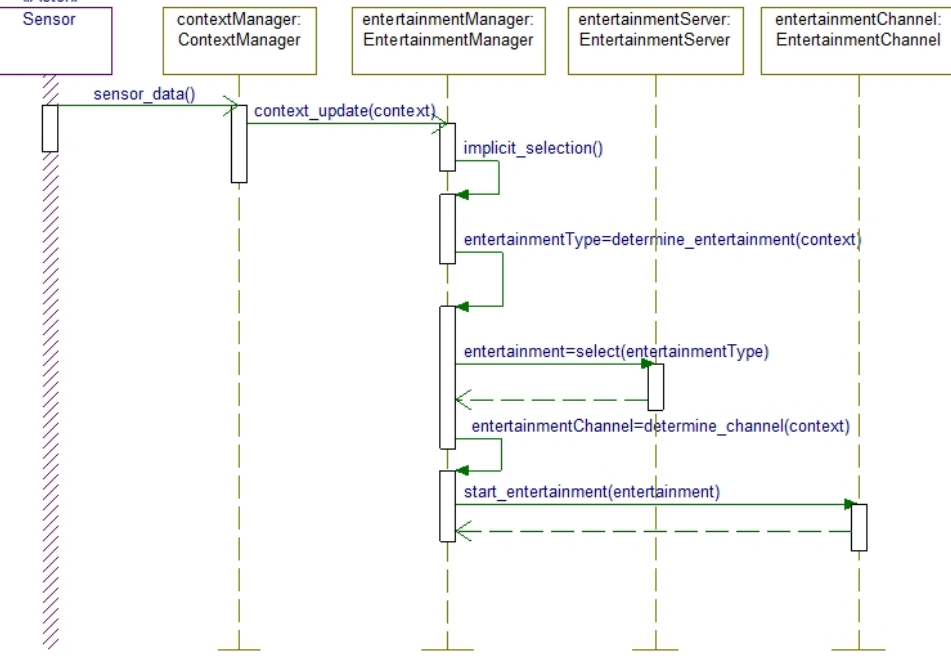
Figure 5. Automatic provision where the ContextManager trigger the particular activity when it receives specific data from the